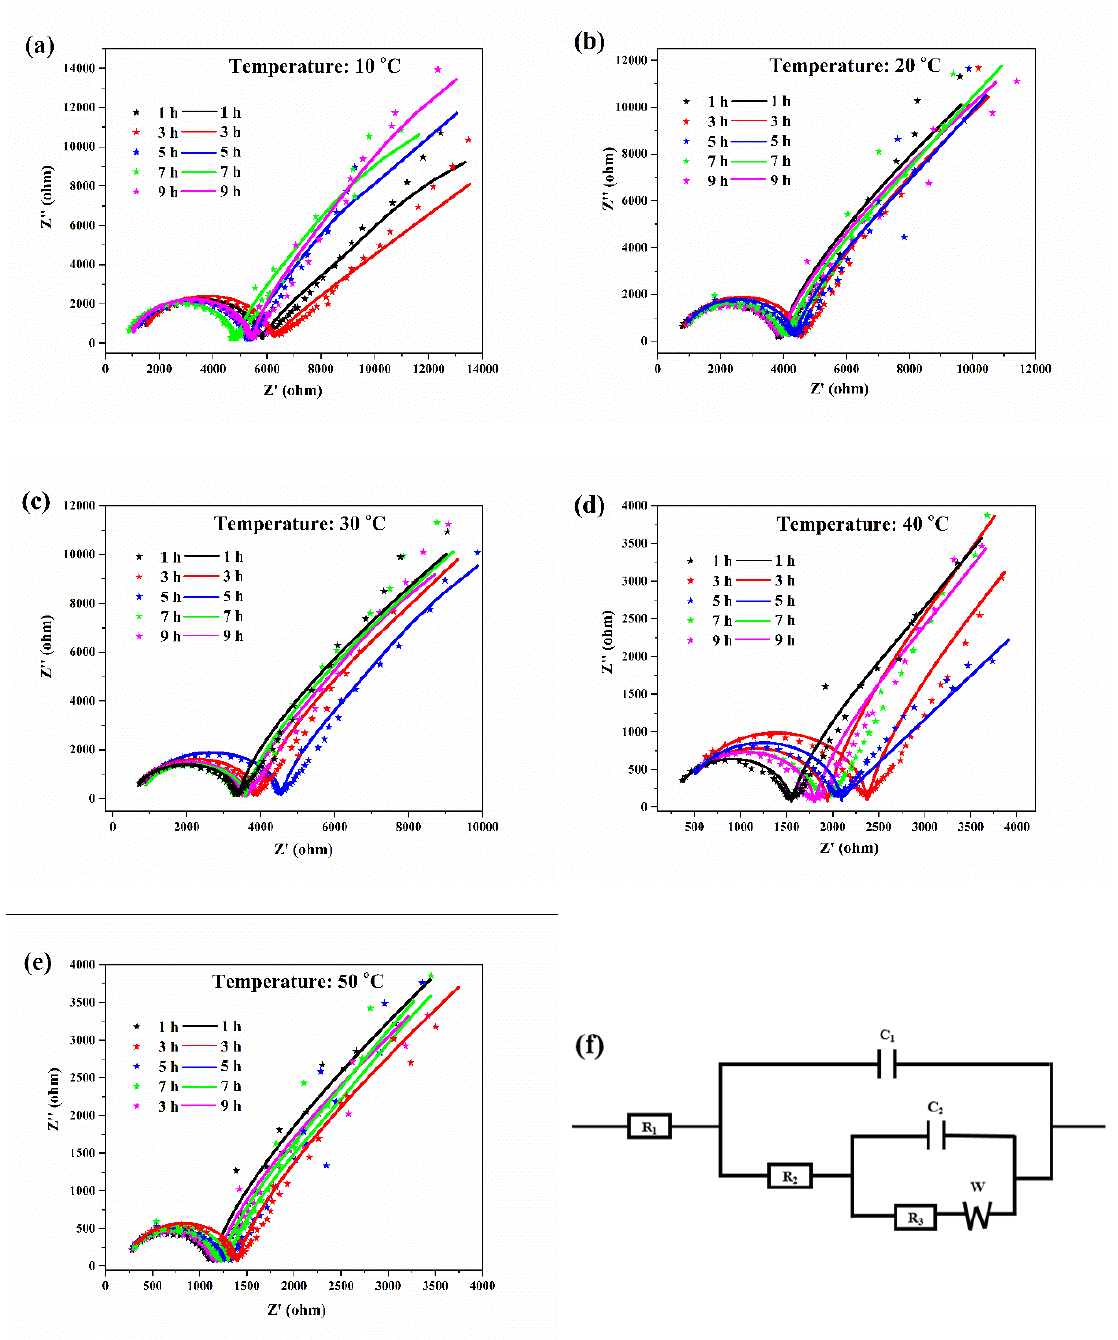
Figure 3. EIS curves for aluminum electrodes in deionized water at 10 ( a ), 20 ( b ), 30 ( c ), 40 ( d ), 50 °C ( e ), and the associated equivalent circuit diagram ( f ). The original data and fitting curves are indicated by the dotted lines and the solid lines, respectively.